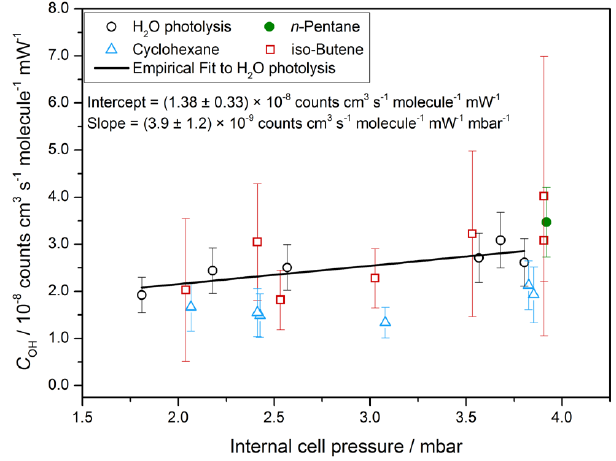
Figure 9. HIRAC FAGE instrument sensitivity to OH, C OH , as a function of internal detection cell pressure as determined by the H 2 O vapour photolysis and HC decay calibration techniques us- ing the Litron Nd:YAG pumped dye laser operating at 200Hz PRF. All calibrations were conducted at laser powers between 6.0 and 9.5mW. Different internal cell pressures (1.8–3.8mbar) were achieved by changing the diameter of the FAGE inlet pinhole be- tween 0.5 and 1.0mm. Conventional calibrations were conducted at constant [H 2 O] vap (4500 ± 600ppmv), whereas alternative calibra- tions were conducted in near-dry conditions ( < 15ppmv). HIRAC Figure 8. Normalised S HO decay for the HCHO photolysis cal- chamber pressures between 440 and 1000mbar were used to induce 2 ibration method at 1000mbar chamber pressure using the aircraft internal cell pressures between 2.1 and 3.9mbar. Error bars indicate FAGE instrument (5kHz PRF laser system) conducted with the the total uncertainty to ± 1 σ HIRAC chamber mixing fans on (a) and off (b) ; inlet pressure = (2.53 ± 0.02)mbar; laser power = (8.25 ± 0.25)mW. Data in ) 0 , (a) were fitted with Eq. (7) to give C HO where A = (S HO 2 2 + HO = C = k = offset, with un- k b = k HO 2 , c HO 2 , k a loss and z 2 certainties quoted to ± 1 σ . Parameters without quoted error were fixed.